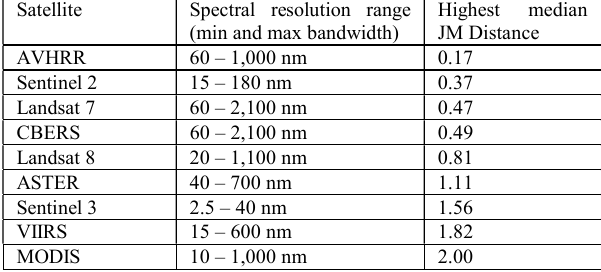
Table 2. Median JM Distance results for common multispectral